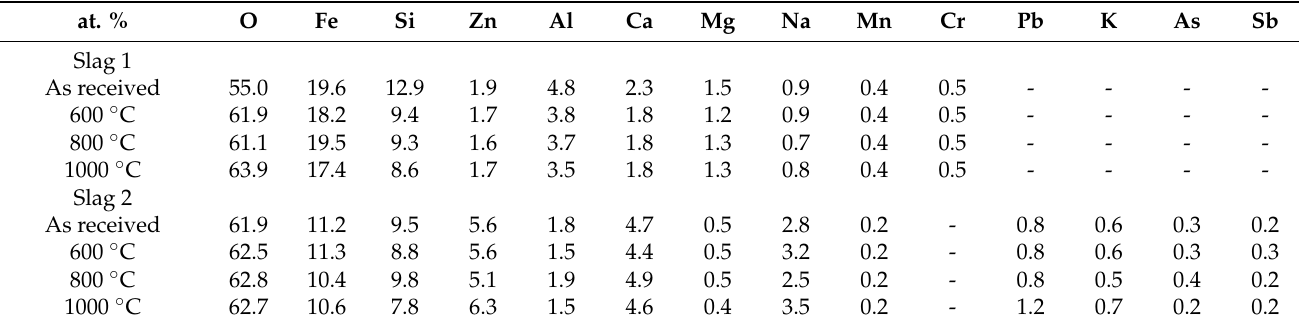
Table 1. Chemical composition of slags 1 and 2 in as-received and annealed